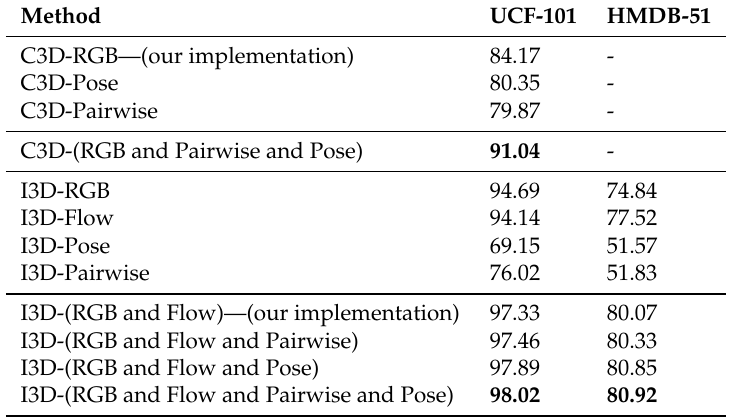
Table 2. The result of using C3D [12] and inflated 3D ConvNet (I3D) [13] as backbone networks for the UCF-101 and HMDB-51